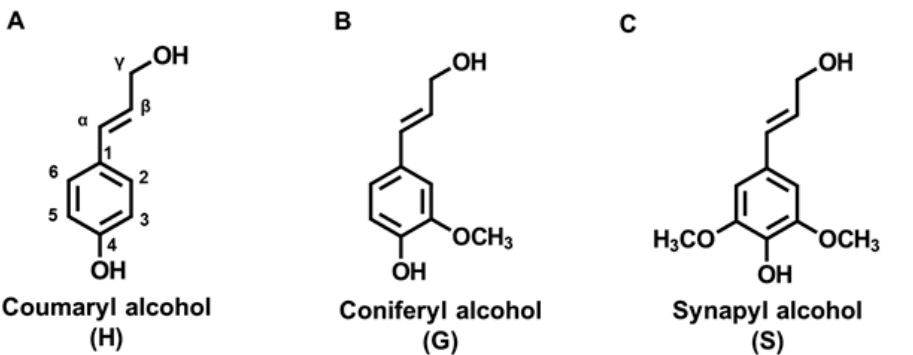
Figure 1. Structure of the monolignol unit precursors of lignins. Coumaryl- ( A ), coniferyl- ( B ) and sinapyl-alcohol ( C ).